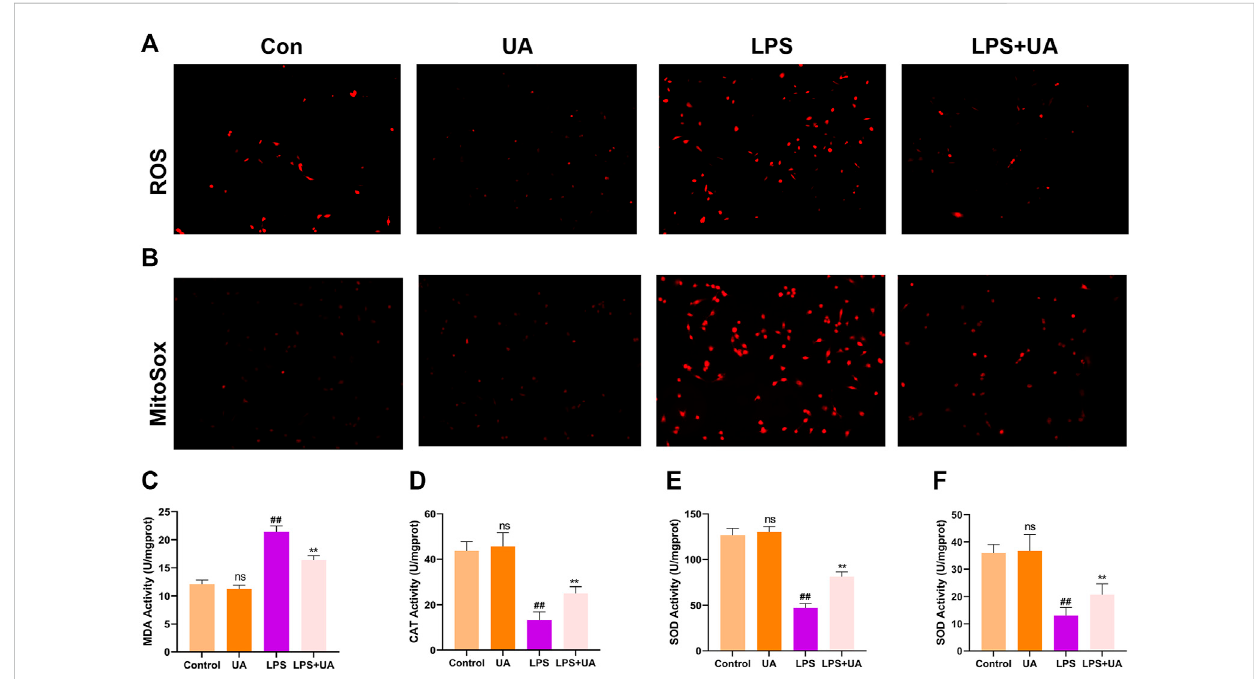
FIGURE 3 EffectsofUrolithinA(UA)onLPS-mediatedOSinALI. (A) Typical imagesshowed theROSlevel inBEAS-2Bcells. (B) Typical imagesshowed MitoSox in BEAS-2B cells. (C – F) MDA, CAT, GSH, and SOD activities in the mouse lung tissues. All data were shown as mean ± SD. ## p < 0.01, ** p < 0.01 in comparison to control and LPS groups,